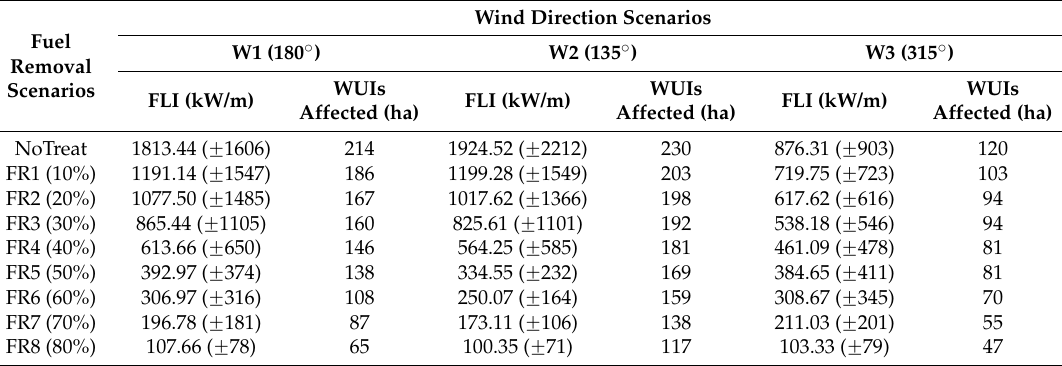
Table 3. Results of simulations performed with FlamMap 5 in each wind and fuel removal scenario to estimate FLI (mean value) and the WUIs affected within the study landscape.